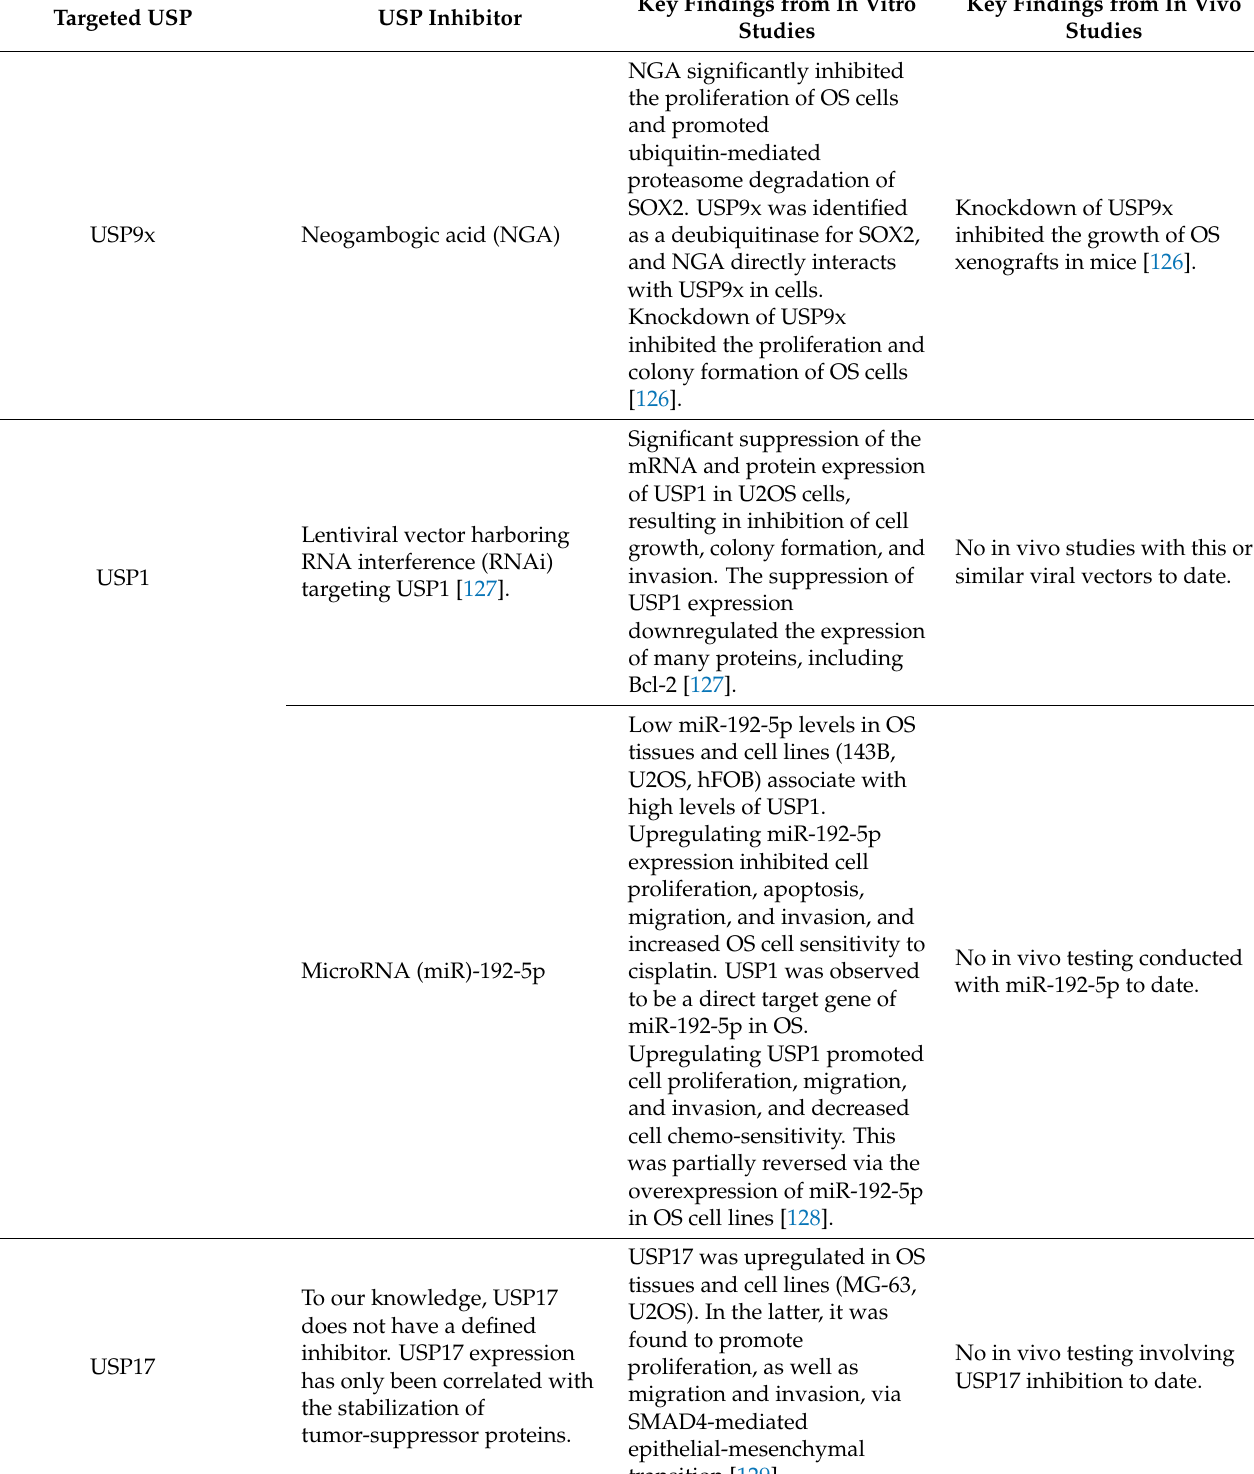
Table 3. Key findings from preclinical research that has explored USP inhibitors in both in vitro and in vivo studies with OS